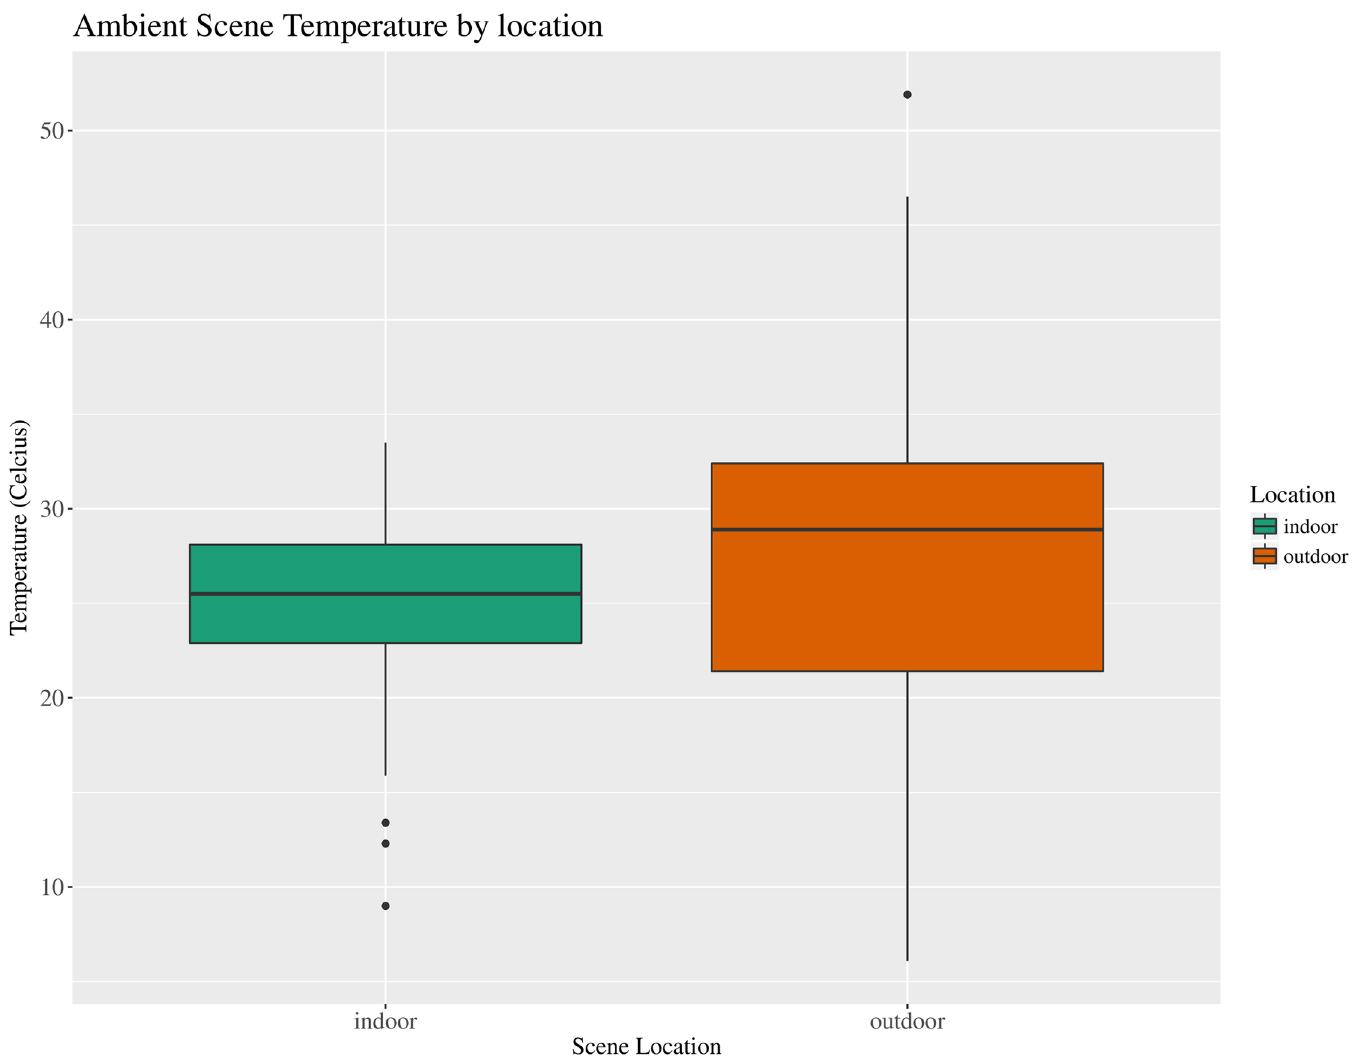
Fig 2. Boxplot of median ambient scene temperature (˚C) by scene location. Boxplot illustrating the median ambientair temperature (˚C) and associated variationrecordednear the decedentat scenes located indoors and outdoors for forensic entomology cases over the study period(January 2013–April 2016). (N =